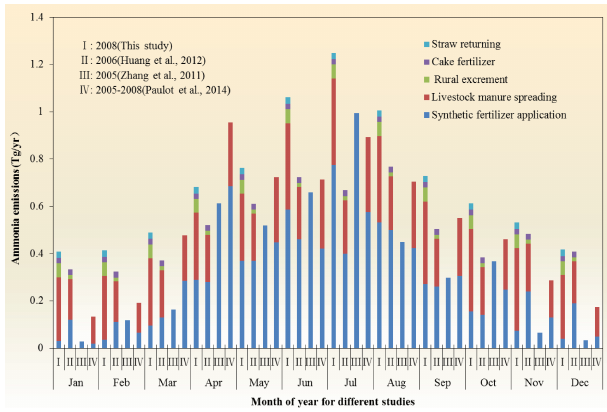
Figure 4. Monthly NH 3 emissions in 2008 and compared with ear- lier